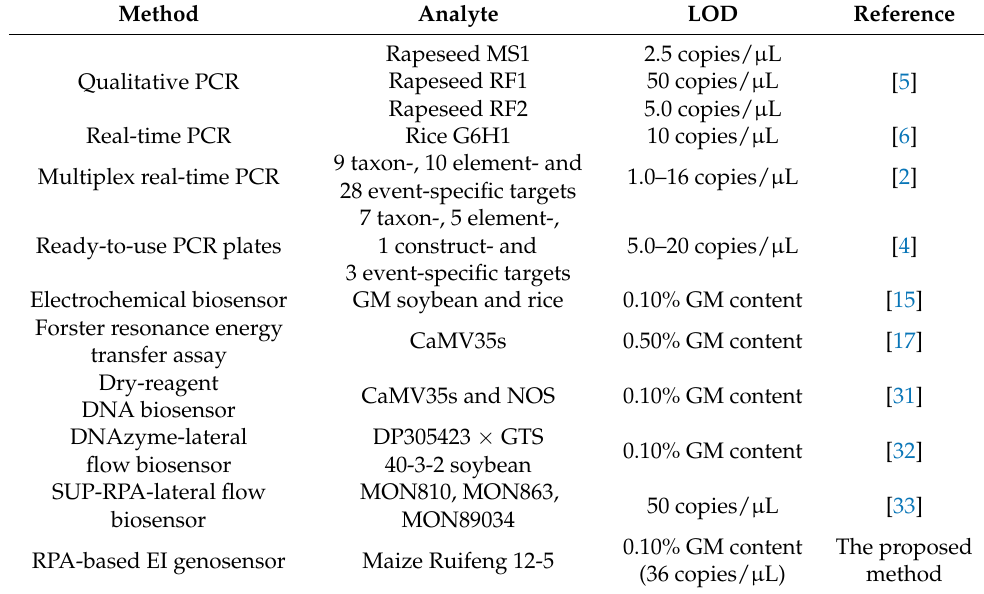
Figure 5. ( A ) R et responses of Ruifeng12-5 genomic DNA at different contents from TE buffer, and NTC and 0.050 – 10% using the developed sensor coupled with RPA; inset: calibration curves, where n = 5 for each point. ( B ) R et responses of non-GM maize, 0.10%, 1.0% and 10% contents of GM maize Ruifeng12-5 using the proposed DNA senor coupled with one-step extraction and RPA methods, five measurements from the same RPA solution for each point; inset: EI spectra. Table 1. Comparison of current available DNA-based methods for the determination of GM